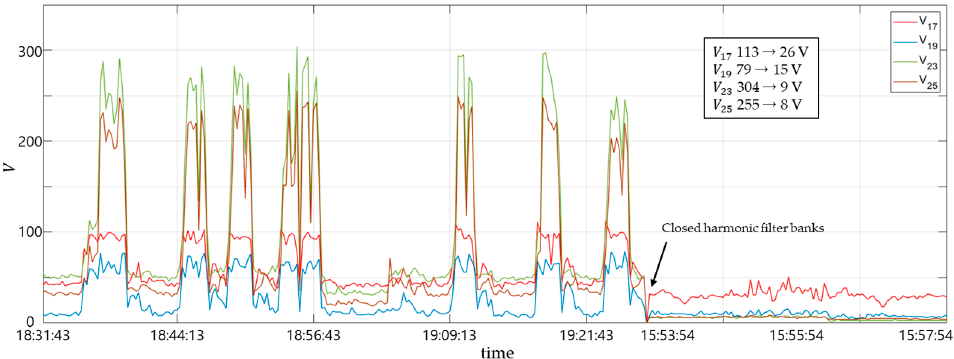
Figure 12. Measured 𝑉 (cid:3035)((cid:2869)(cid:2875),(cid:2869)(cid:2877),(cid:2870)(cid:2871),(cid:2870)(cid:2873)) on 22 kV system.